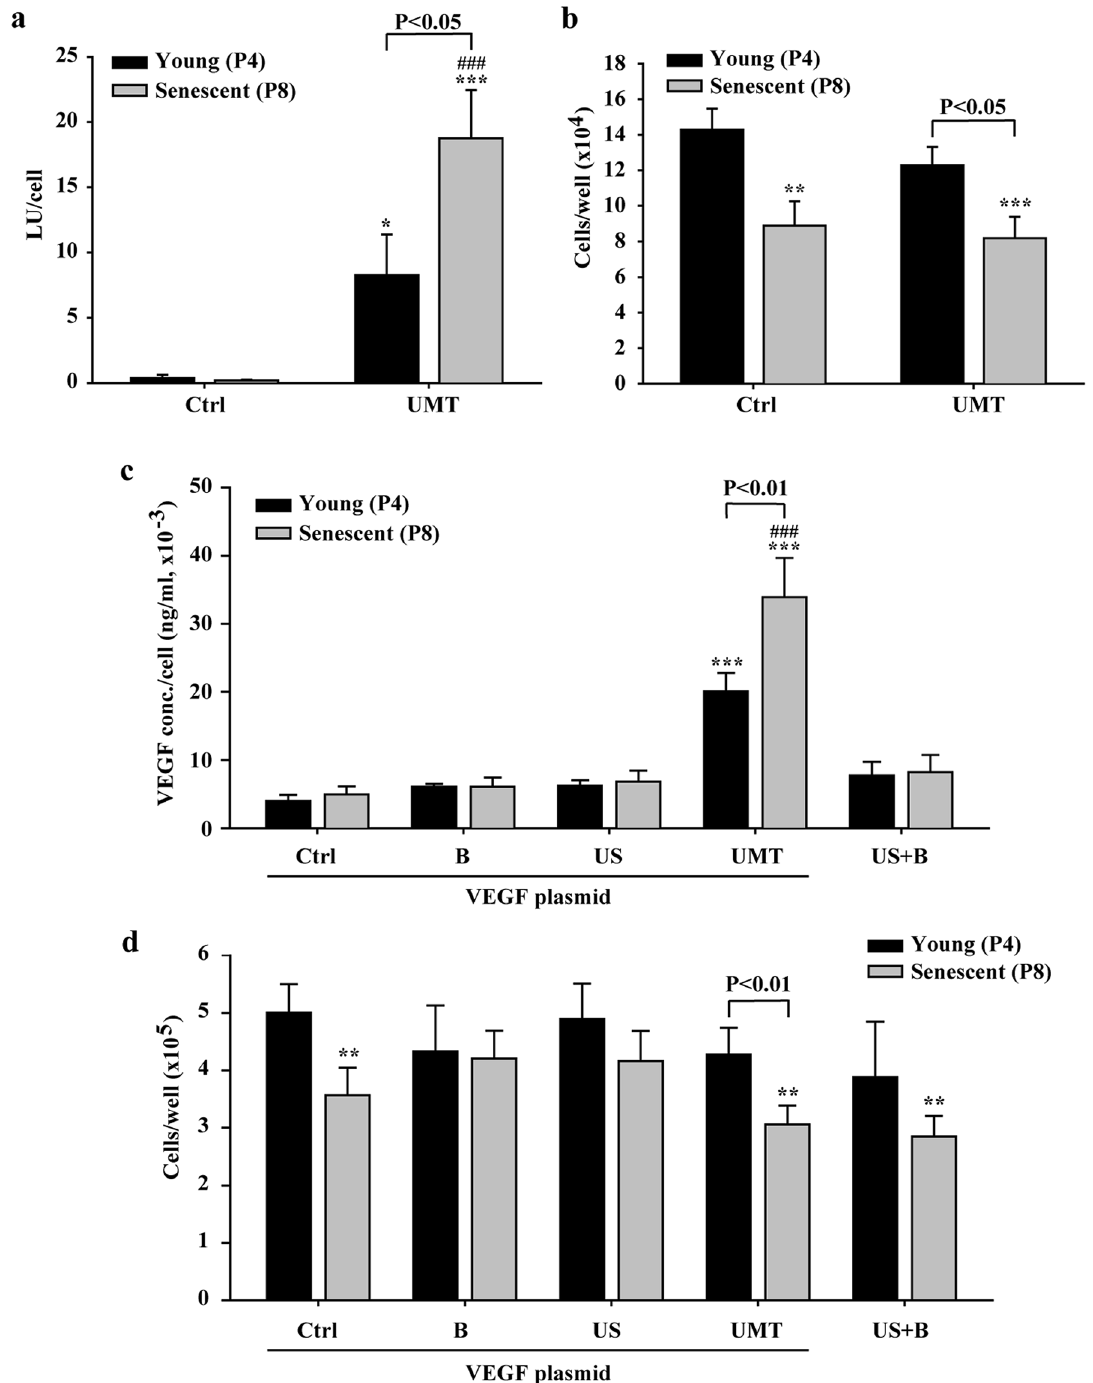
Figure 2. Efficacy of ultrasonic microbubble transfection (UMT, i.e., US + B + plasmid) in young and senescent EPCs and the effect on the cell number at 48 h after treatment, as evaluated by a luciferase assay ( a ), by cell counting with a Coulter counter ( b and d ) and by ELISA for VEGF expression ( c ). In ( c ) and ( d ), the cells were divided into 5 groups to evaluate the treatment effects of US and microbubbles in the presence or absence of plasmid on VEGF expression and the cell number. The VEGF plasmid was used in all groups except the “US + B” group. The luminescence intensity generated by luciferase expression and the expression level of the VEGF protein (in 1000 μl of pDNA-containing growth medium per well) are shown per cell ( a and c ). n = 9 for each bar. Note that ( b ) shows the number of remaining cells per well after UMT under the conditions used in ( a ), and that ( d ) shows the number of remaining cells per well after treatment under the conditions used in ( c ). Additionally, note that for the UMT groups, differences between the black and grey bars are indicated. * P < 0.05; ** P < 0.01; *** P < 0.001 vs. the leftmost black bar and ### P < 0.001 vs. the leftmost grey bar. Ctrl = control. B = microbubbles. US = ultrasound. LU = luminescence